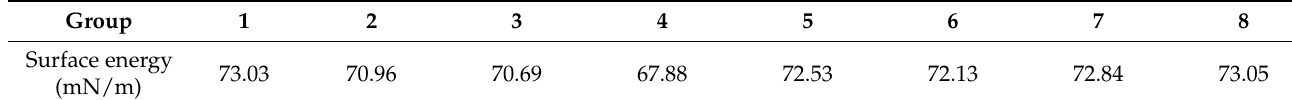
Table 3. Surface energy of each group of samples.